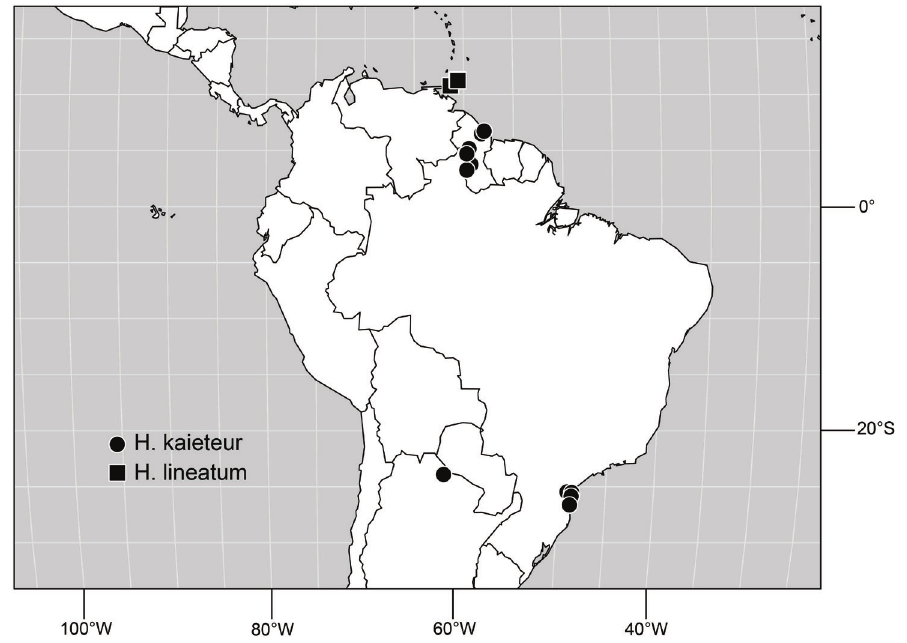
Figure 100. Distribution of Hydrochasma kaieteur sp. n. and H. lineatum sp.